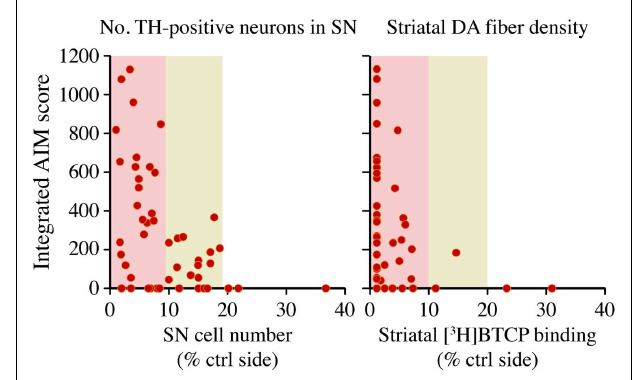
FIGURE 4 |A large nigrostriatal DA lesion is necessary but not sufficient for therapeutic L -DOPA doses to induce dyskinesia . Rats sustained unilateral nigrostriatal DA lesions of varying severity, and were then treated with L -DOPA (6mg/kg/day) for 4weeks. Diagrams plot the animals cumulative Abnormal Involuntary Movement (AIM) scores ( y axis) on presynaptic markers of DA neuron integrity, that is, tyrosine hydroxylase- positive cells in the substantia nigra (SN) or striatal innervation density, estimated with DAT radioligand binding using [ 3 H]-BTCP. Data collected on the side ipsilateral to the lesion are expressed as a percentage of the values on the contralateral (ctrl) intact side.With either measure, AIM scores were found to occur only in animals that had lost more than 80% of presynaptic dopaminergic markers, and maximally severe AIMs occurred only when this loss exceeded 90%. Note however that some of the completely DA-denervated animals did not develop any dyskinesia.The dataset is derived from Ref.